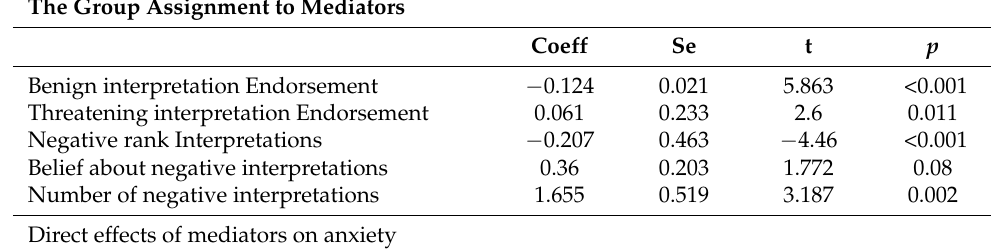
Table 3. The result of the mediation